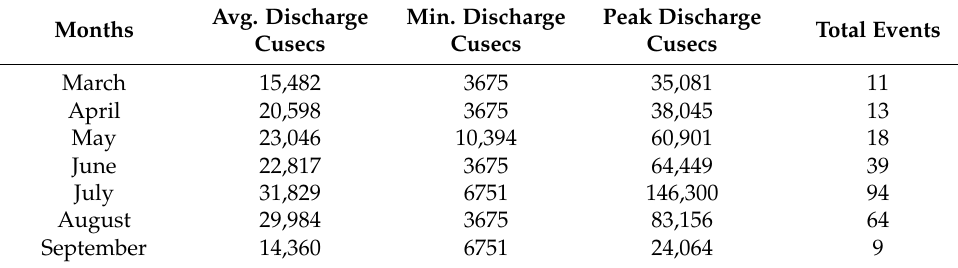
Table 1. Event frequency of Sanghar torrent.